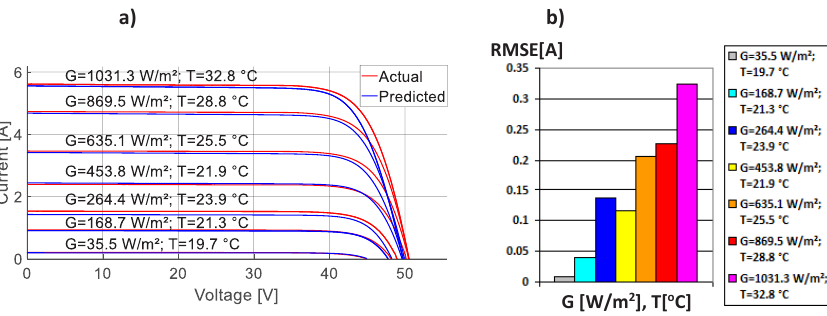
Figure 9. Comparison between the calculated (proposed model) and experimental curves of operation conditions of the amorphous silicon Cocoa HIT05667 PV panel: ( a ) Graphical comparison; ( b ) RMSE of proposed model.